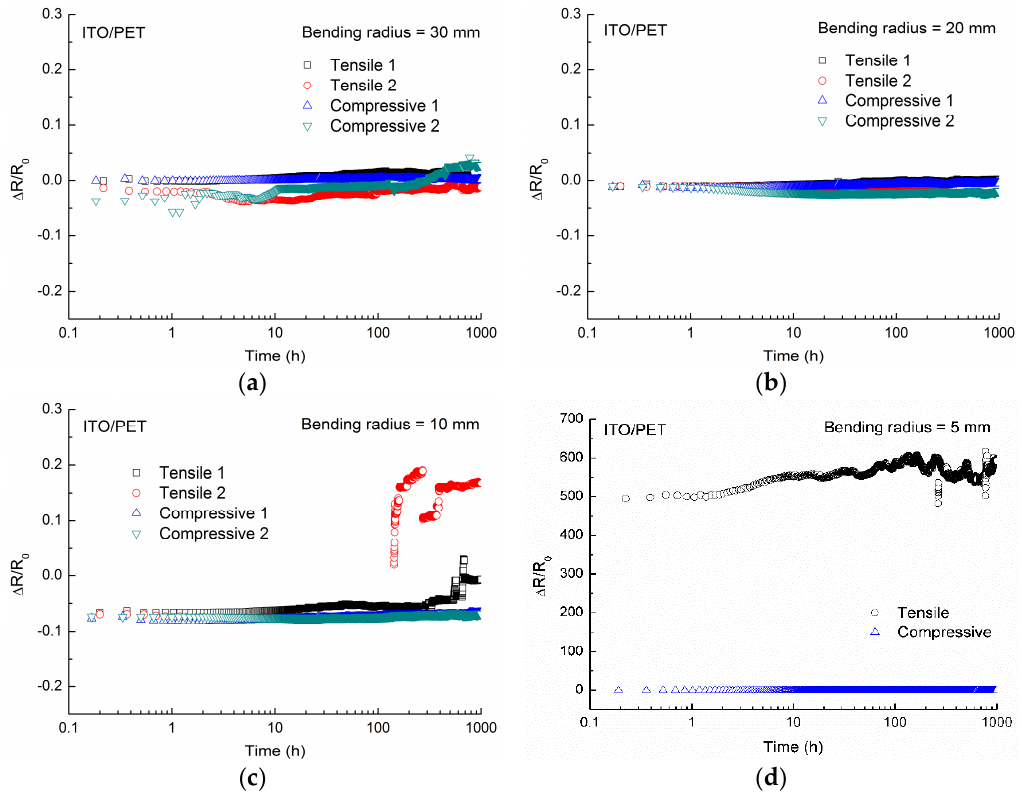
Figure 4. Electrical resistance change of ITO/PET (polyethylene terephthalate) sheet under static bending of various radii: ( a ) 30 mm; ( b ) 20 mm; ( c ) 10 mm; and ( d ) 5 mm.